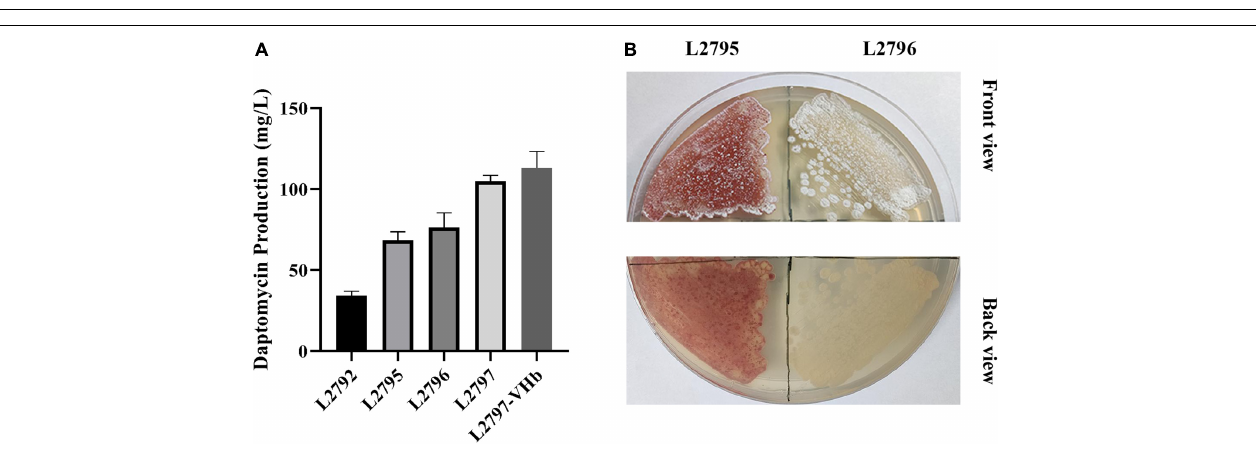
( Figure 3A ). In the fed-batch fermentation of 15 L fermenter, the ability of the resultant strain L2797-VHb to produce daptomycin reached as high as 786 mg/l, an increase of 24%, compared with the parent strain L2797 ( Figure 4B